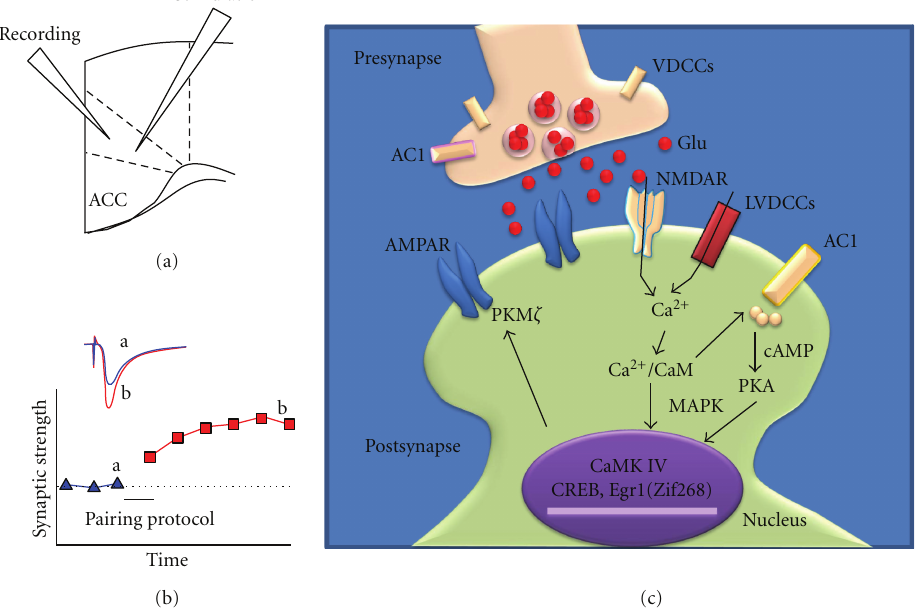
Figure 3: A cellular model for ACC plasticity. (a) Diagram of an ACC slice showing the placement of whole-cell patch recording and stimulation electrode. (b) LTP is induced by 80 pulses at 2Hz with postsynaptic holding at +30mV. (c) Activations of postsynaptic glutamate NMDA receptors or L-VDCCs lead to an increase in postsynaptic Ca 2+ in dendritic spines. Ca 2+ binds to CaM and leads to activation of calcium-stimulated ACs, mainly AC1 and other Ca 2+ /CaM-dependent protein kinases (PKC, CaMKII, and CaMKIV). Subsequently, GluA1- containing AMPA receptor will undergo the upregulation. Activation of CaMKIV, a kinase predominantly expressed in the nuclei, will trigger CREB signaling pathways. In addition, activation of AC1 leads to activation of PKA, and subsequently CREB as well. MAPK/ERK could translocate from the cytosol to the nucleus and then regulate the CREB activity. Postsynaptic PKM ζ is critical for maintaining synaptic potentiation in the